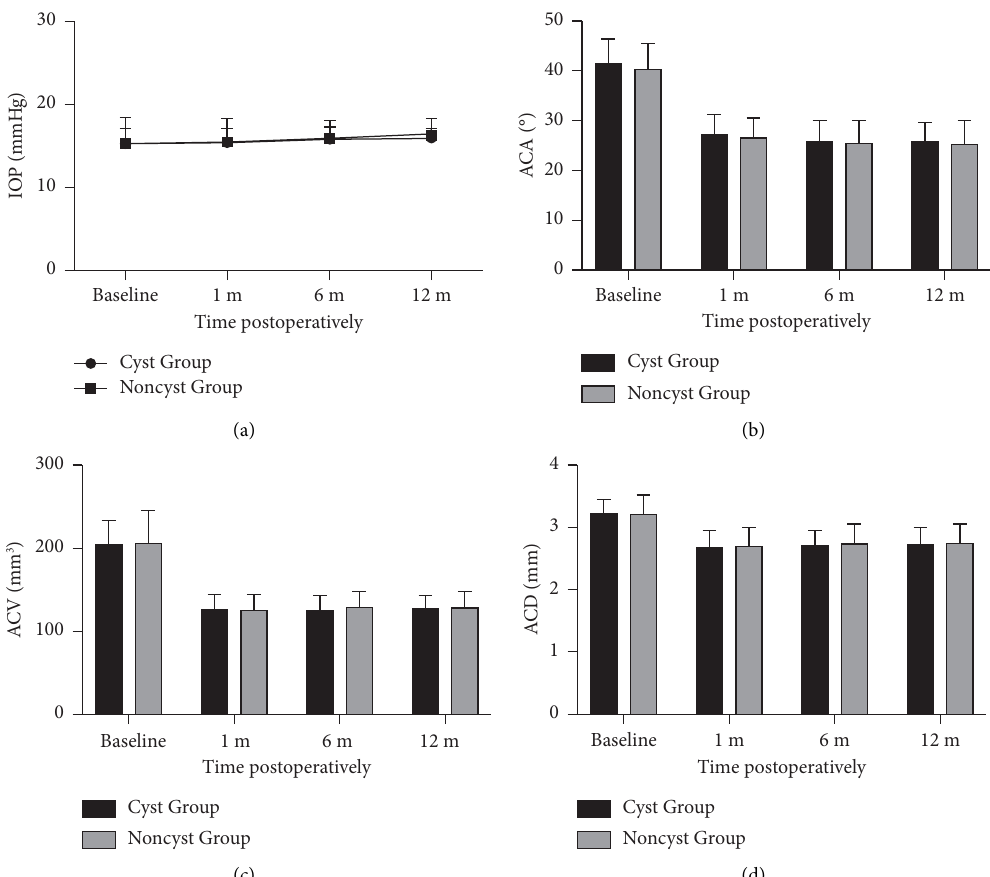
Figure 3: Mean IOP (a), ACA (b), ACV (c), and ACD (d) of the cyst group and the noncyst group at each follow-up at diferent time points. ∗ P < 0 . 05, the error bar indicates the standard deviation.